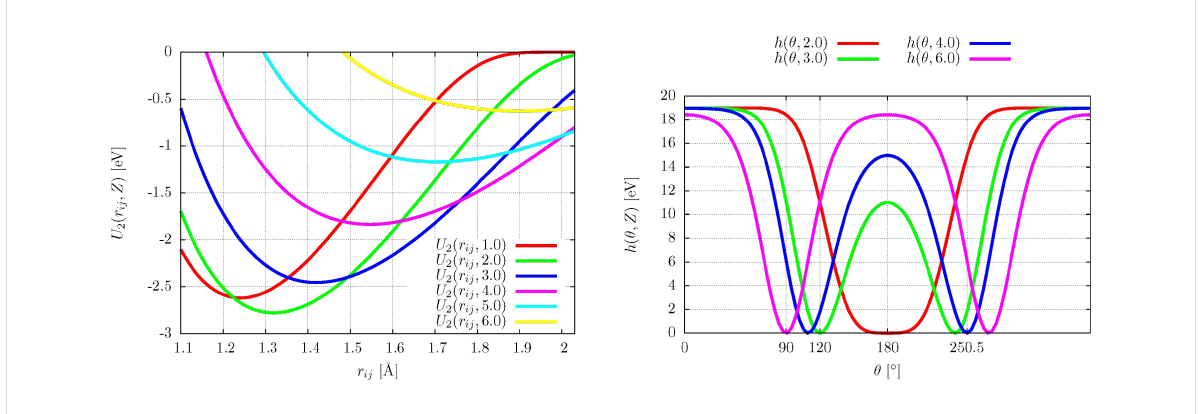
Figure 1: Pictorial representation of the major ingredients of the carbon–carbon potential in Equation 1, compare also [9]. L.h.s.: radial dependence of the two-body potential for various coordination numbers. R.h.s.: coordination number dependence of angular-dependent part of the three-body poten-